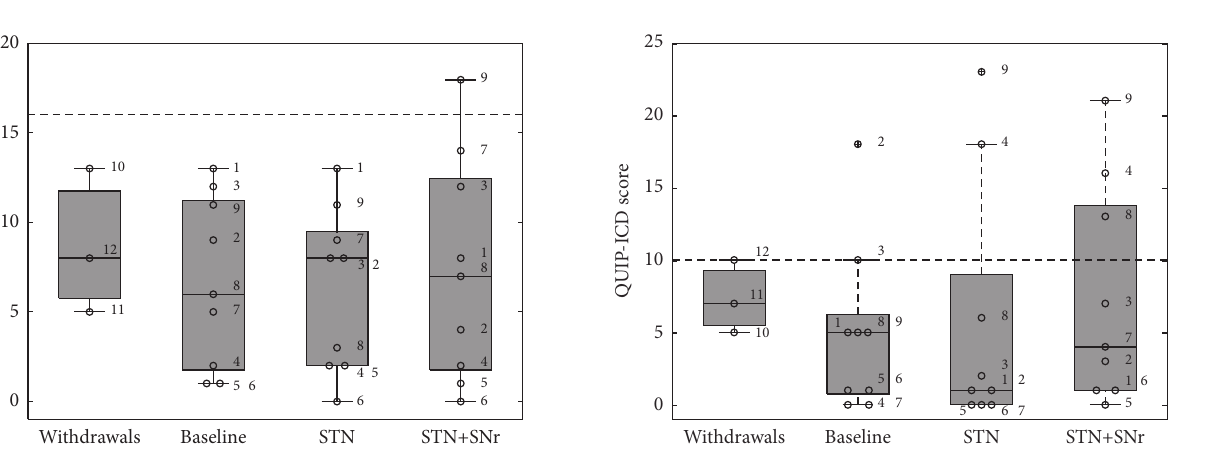
Figure 6: Boxplots of BDI-I scores: the box plot depicted on the left represents the baseline values of the three patients who withdrew. The other three box plots represent the values of the 9 PD patients who have completed the study at the three experimental time points: (1) baseline, (2) STN alone, and (3) combined STN+SNr-DBS. The numbered circles represent the single patients as listed in Table 1. The dashed horizontal line represents the cut-off for PD patients as previously discussed in Material and Methods.